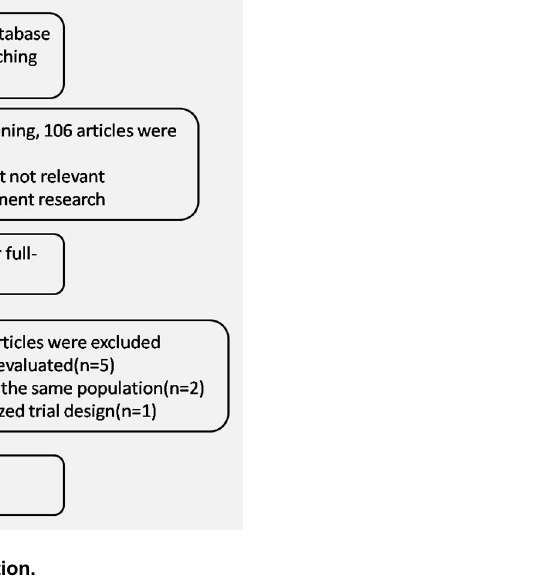
Fig. 1. Flow chart of the study